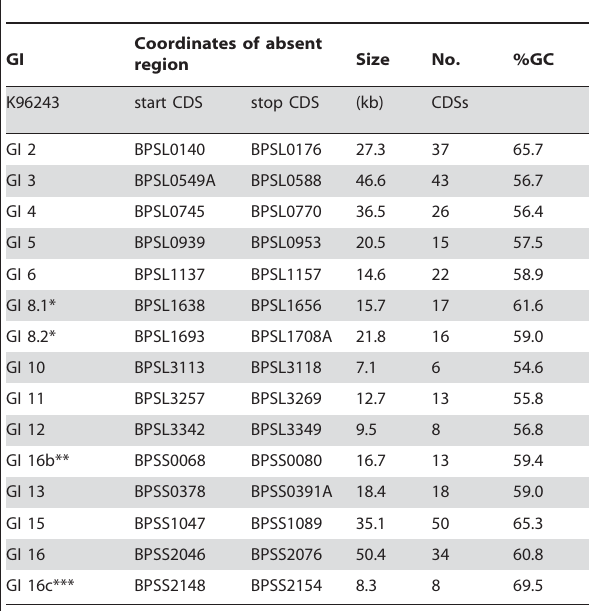
Table 1. Summary of the genomic islands (GIs) identified to be absent in tested isolates when compared with GIs in the